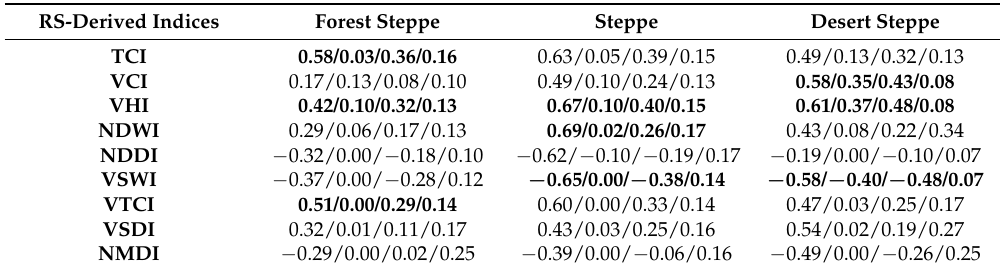
Table 4. R of soil moisture at a depth of 10 cm and the RS-derived indices in the three land-cover types across stations (at a 99% confidence